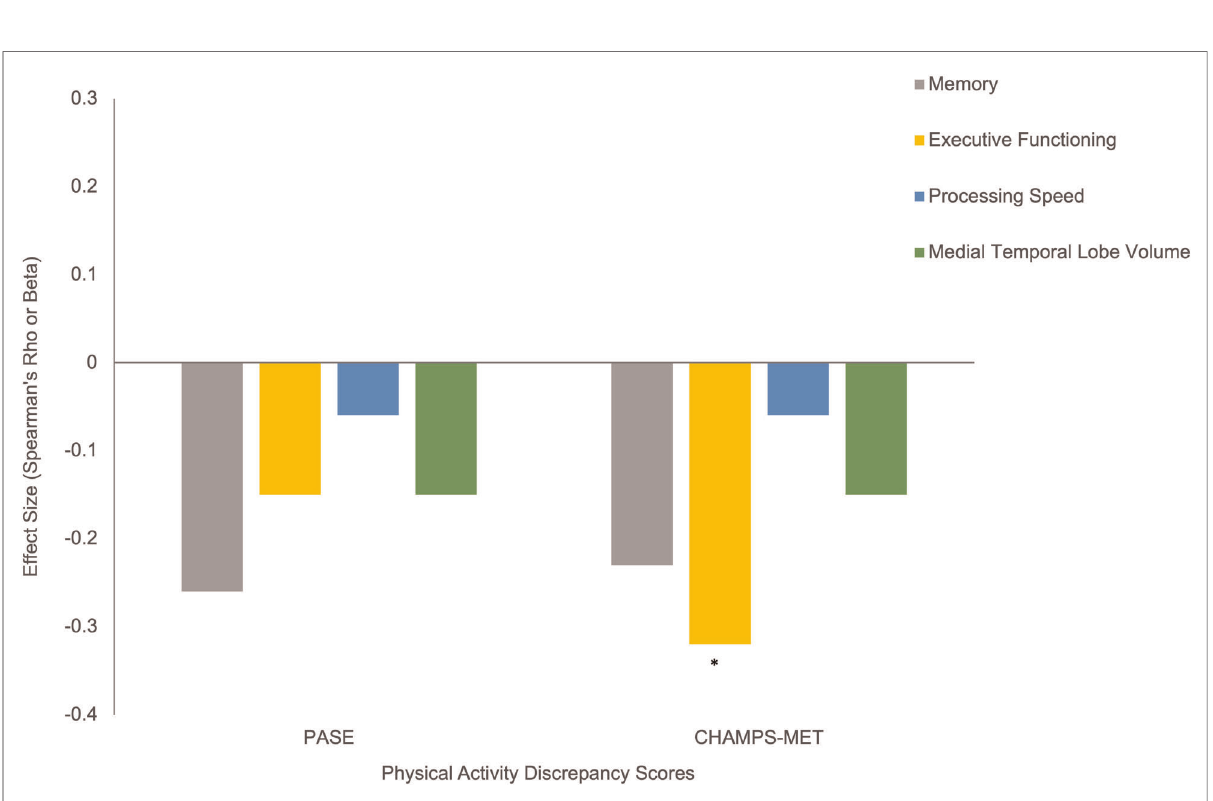
FIGURE 5 Cognitive correlates of physical activity overreporting (positive discrepancy score indicates greater overreporting). Note. *Statistically signi fi cant at p